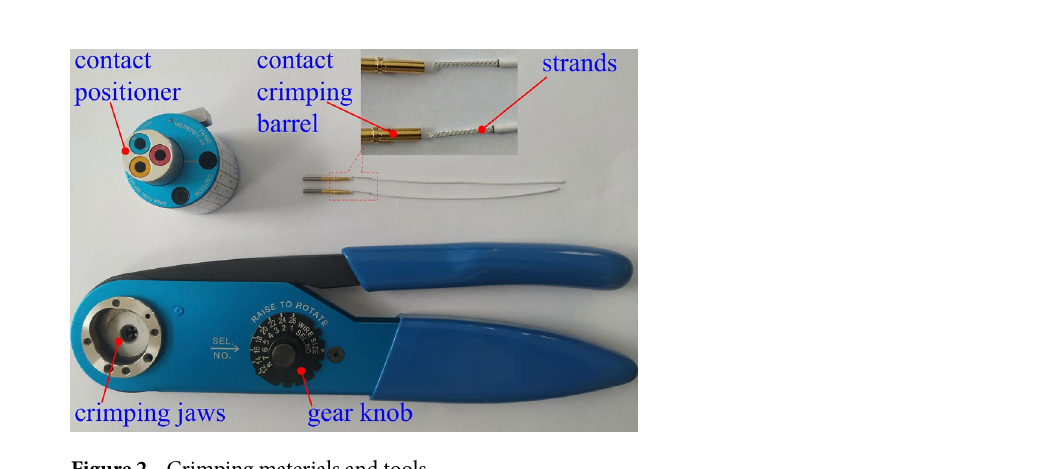
Figure 2. Crimping materials and